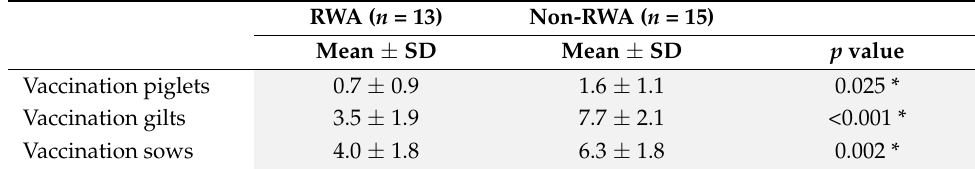
Table 4. The number of pathogens (mean ± SD) against which piglets, gilts, and sows were vaccinated on the Raised Without Antibiotics (RWA) ( n = 13) and the non-RWA pig farms ( n = 15). p values are provided for a comparison between RWA and non-RWA farms based on an independent samples t -test. RWA ( n = 13) Vaccination piglets Vaccination gilts Vaccination